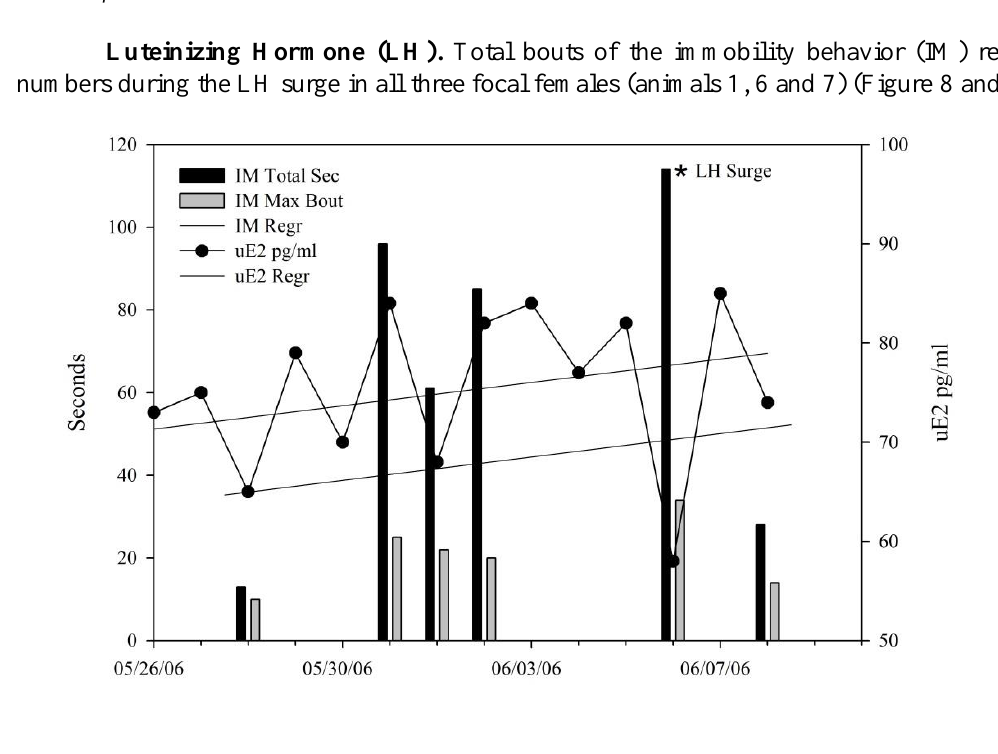
Figure 8 . Animal 1 immobility, uE2, uLH and